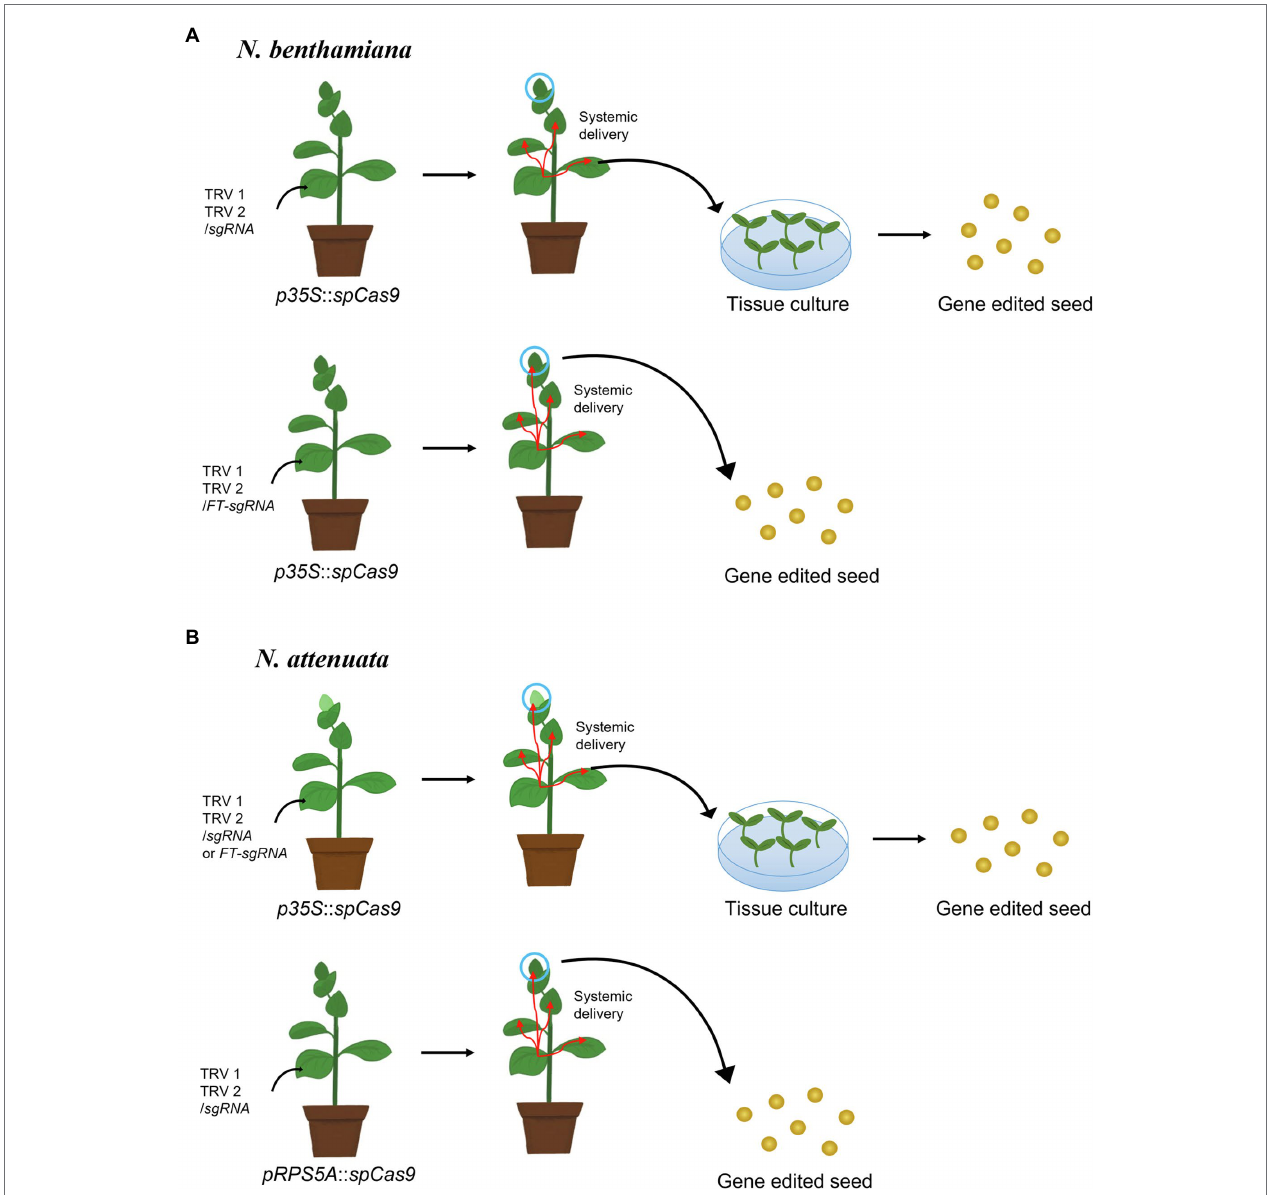
FIGURE 3 | Schematic illustration of tobacco rattle virus (TRV)-mediated seed genome editing in tobacco relatives. (A) In Nicotiana benthamiana , a TRV construct harboring a sgRNA cloned downstream of the Arabidopsis flowering locus T mRNA (TRV2/ FT- sgRNA) delivers the sgRNA efficiently into the germline, while TRV/sgRNA does not. In addition, the 35S promoter can drive transcription in the germline of N. benthamiana . Therefore, infiltration of Agrobacterium cells carrying TRV2/ FT- sgRNA into N. benthamiana leaves expressing SpCas9 from the 35S promoter results in high-efficiency genome editing in seeds (Ellison et al., 2020). (B) In Nicotiana attenuata , infiltration of TRV/sgRNA or TRV2/ FT- sgRNA into N. attenuata plants expressing SpCas9 from the 35S promoter does not lead to genome editing in seeds, as the 35S promoter is insufficient to induce the germline mutation in N. attenuata . However, the RPS5A promoter can induce high gene expression levels in the germline, resulting in genome editing in seeds when leaves are infiltrated with TRV2/sgRNA into N. attenuata plants expressing RPS5A-driven SpCas9 (Oh and Kim,